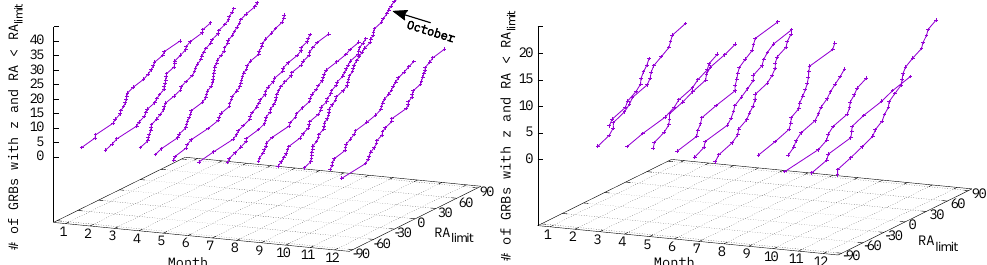
Figure 7. The N ( >RA ) cumulative number of GRBs as a function of the RA right ascension, for every month. Current data were used. The data were divided according to the observational method (afterglow or host galaxy). The afterglow and host galaxy measurements follow approximately the same pattern, except the afterglow’s October distribution. It was created probably by other factors, such as a dedicated rapid response fall